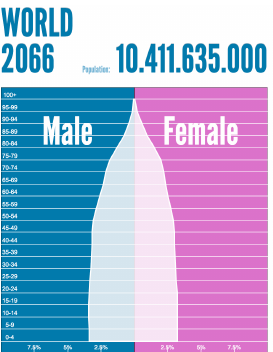
Figure 3: Age pyramid for the World Population in 2066. (Populationpyramid.net,